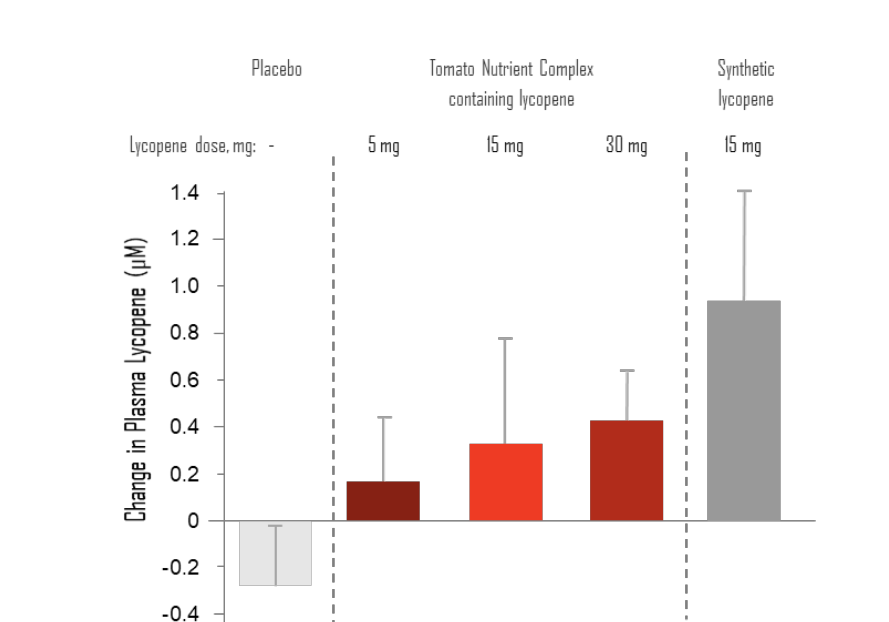
Table 6. Plasma lycopene value at baseline and at eight weeks of treatment.